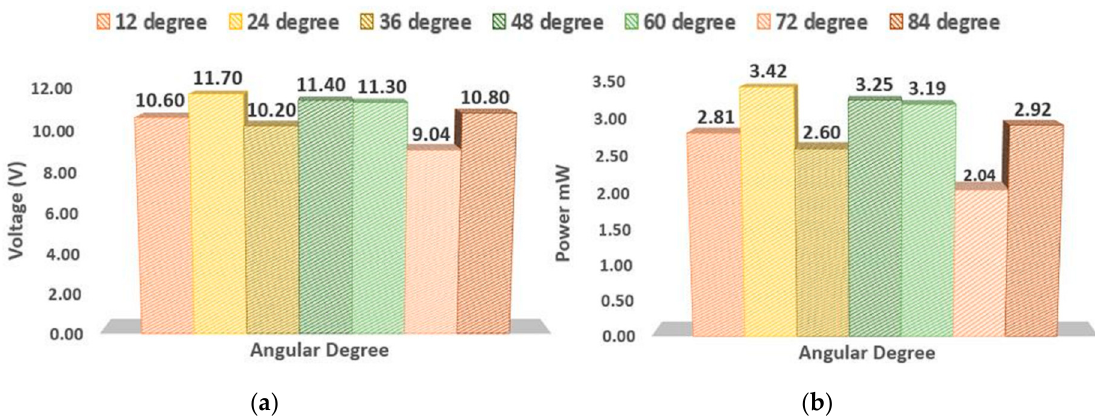
Figure 17. Effect of distance between two cantilevers on ( a ) output voltage and ( b ) output power.